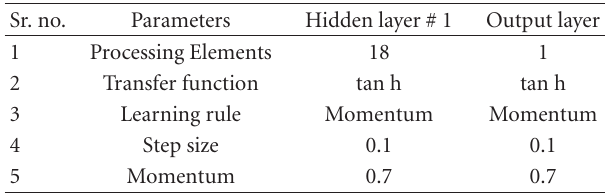
Table 3: Parameters of FTLR NN (Benchmark data). Number of